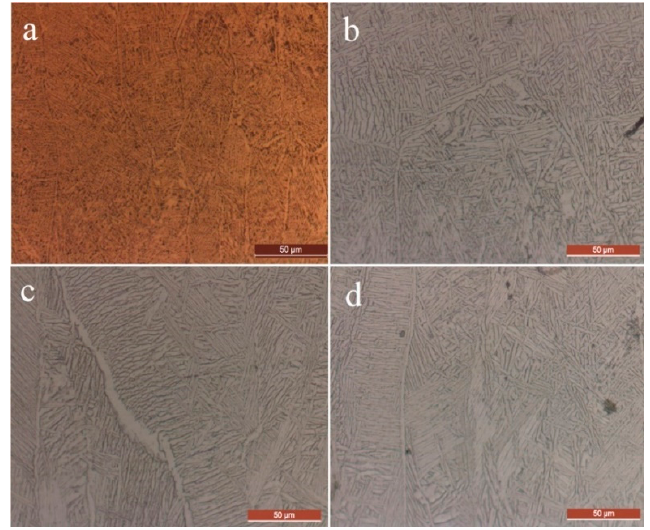
Figure 7. Optical images of microstructures in the bottom region (near the build plate) for the a – d sample disks.